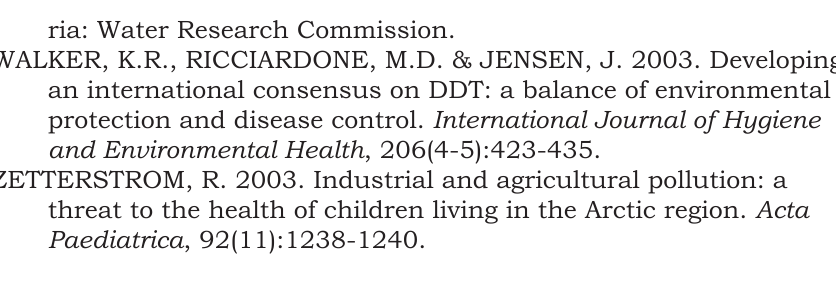
Tabel : Opsomming van vorming, gebruik en eienskappe van die 2 POPs, tans in die Stockholm Konvensie. Naam Opsetlik Vervaardig Nie-opsetlik vervaardig Bronne, gebruik en toksiese eienskappe Anneks * Aldrien Pestisied Geen of min produksie, verban in meeste lande, beperkte gebruik in sommige lande. A Word nog geproduseer, meestal gebruik teen termiete, verban in meeste lande, beperkte ge- Chlordaan Pestisied